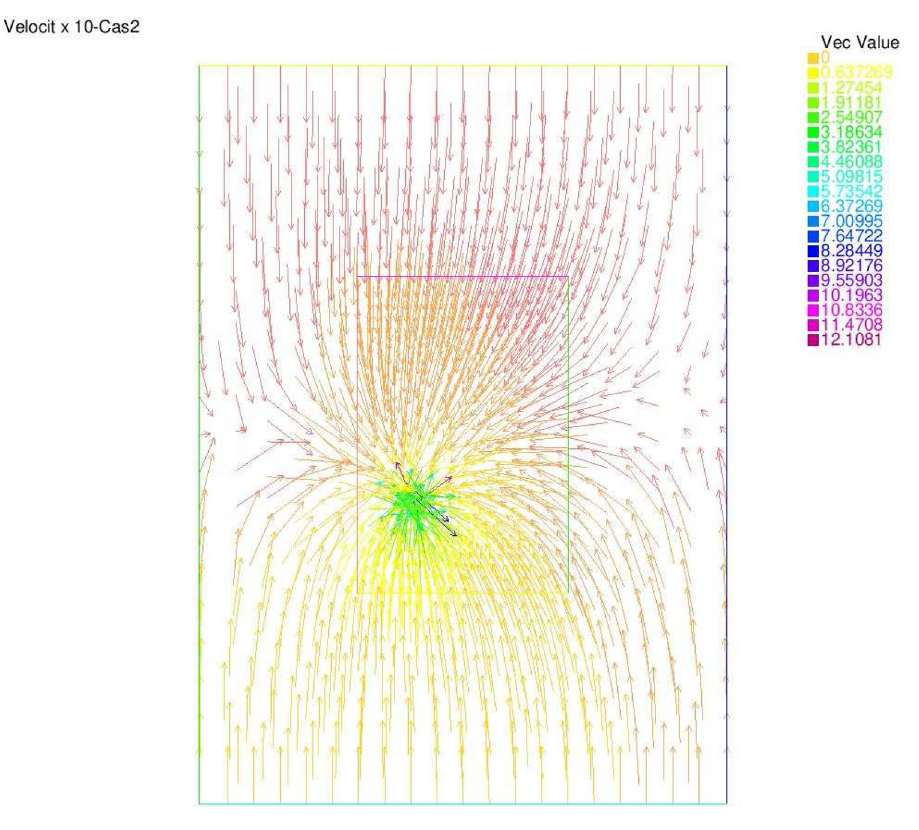
Figure 7. Velocity × 10—Case